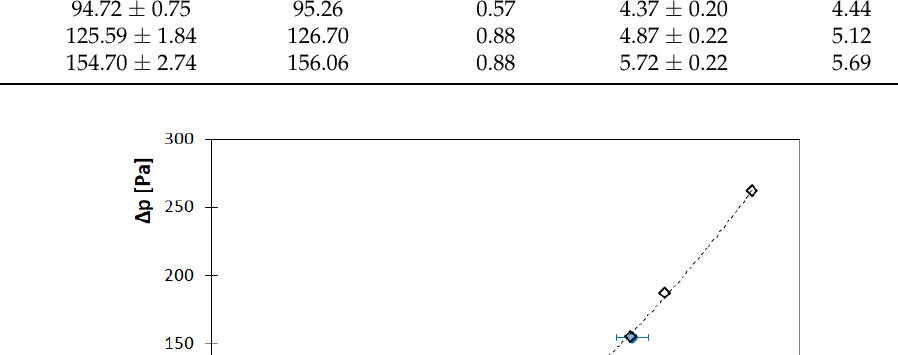
Table 3. Comparison of numerical and experimental results.